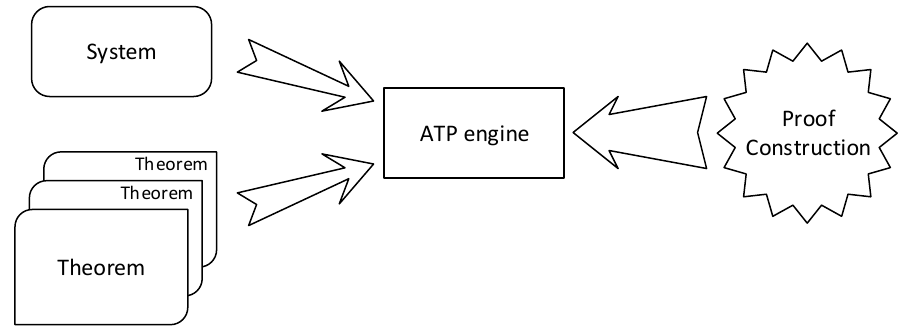
Figure 1. Automated Theorem Proving high-level